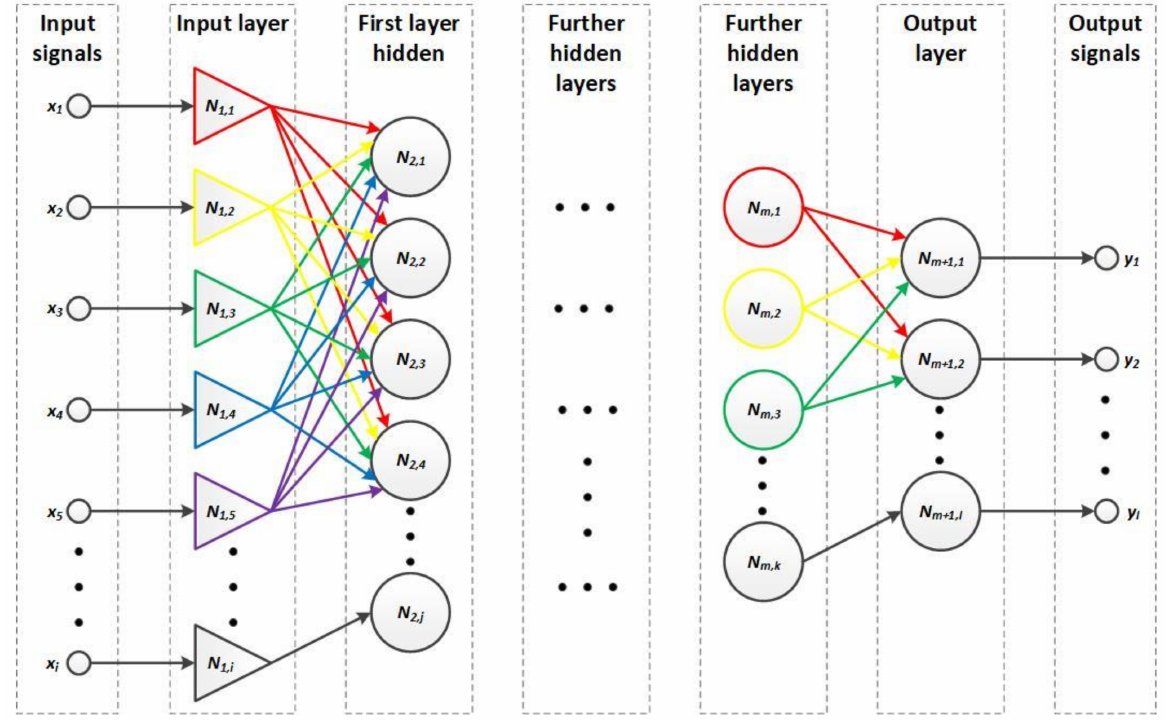
Figure 6. General structure of a typical multilayer neural